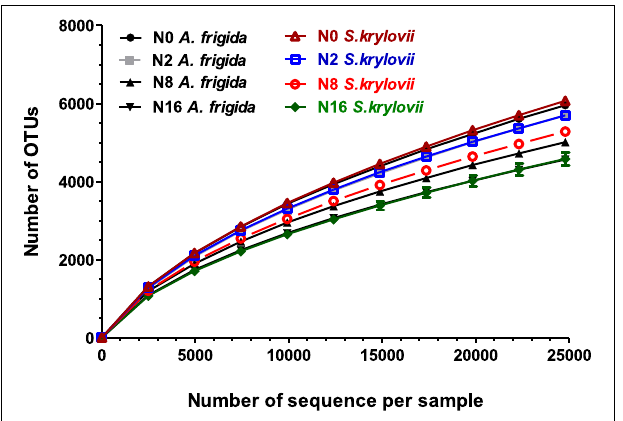
FIGURE 2 | Rarefaction curves of all samples were generated for microbial OTUs which contained unique sequences and were defined at 97% sequence similarities.